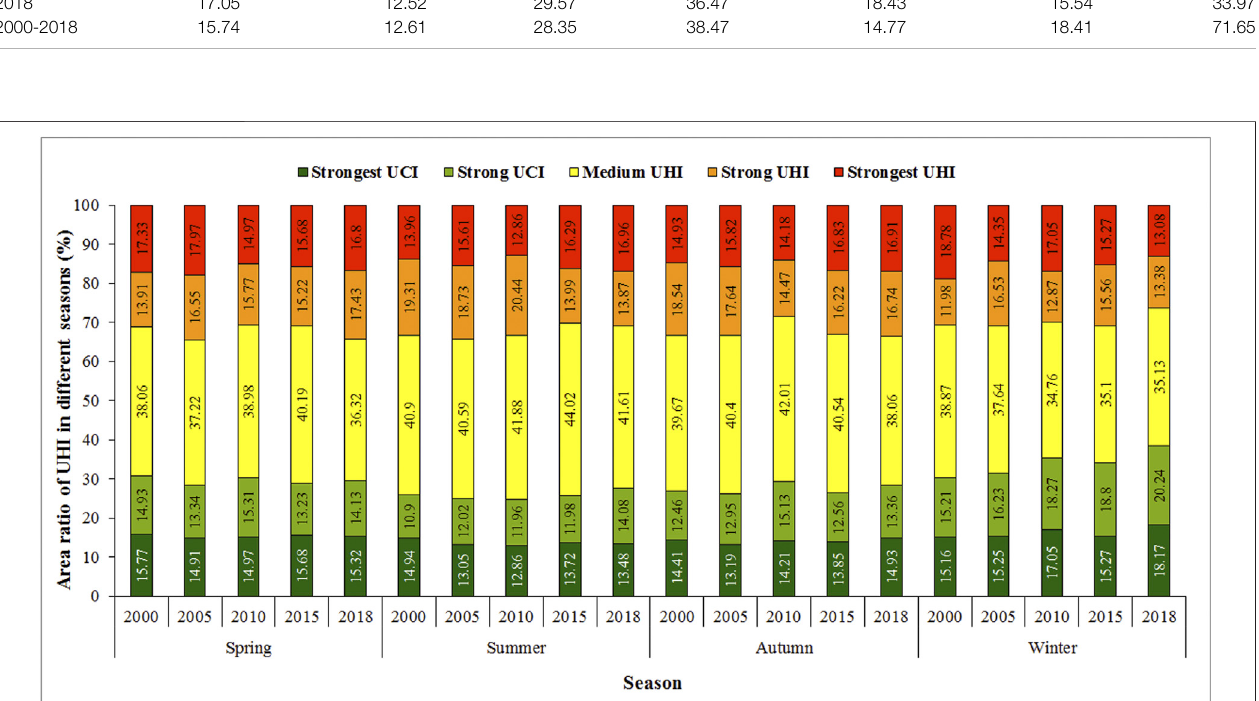
Frontiers in Environmental Science |